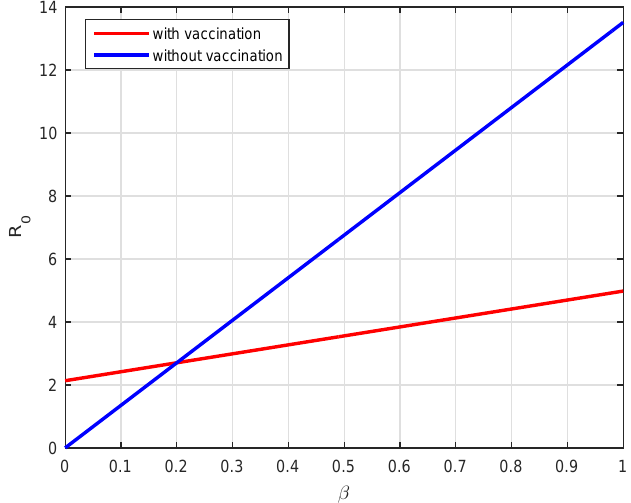
Figure 11. Comparison of the basic reproduction number with vaccination and without